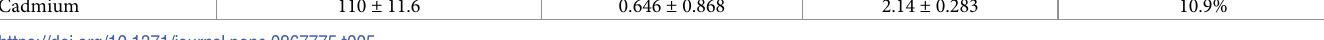
Table 5. Performance of the developed and optimized sample preparation method for cadmium. Element